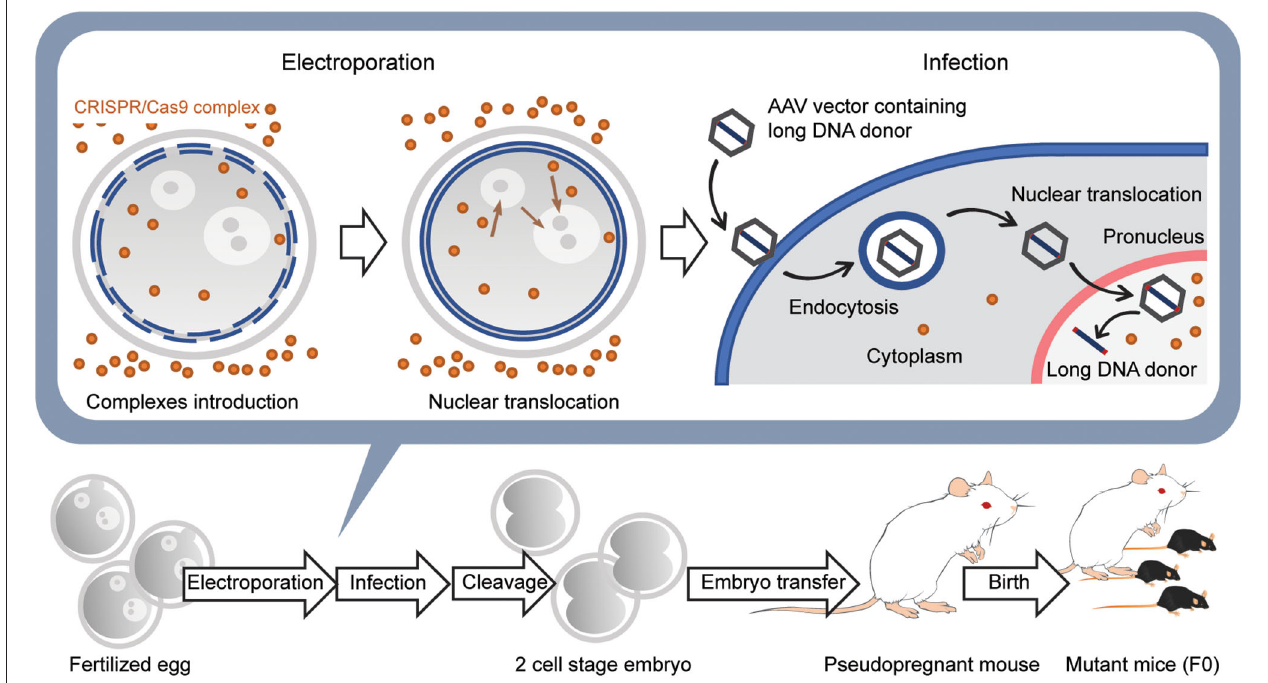
FIGURE 5 | Generation of knockin mice with a long transgene using AAV viral vectors. First, CRISPR/Cas9 complexes are introduced into the fertilized egg using electroporation without long DNA donors. Next, the embryos are moved to the medium containing the AAV vector with the long DNA donor and infected with the viral vectors. The AAV vectors are introduced into the cytoplasm by endocytosis and then translocated into the nucleus using several pathways. The long DNA donors contained in AAV vectors are released in the nucleus and are used for HDR together with the CRISPR/Cas9 complex that was previously transferred into the nucleus. Embryos developed at the 2-cell stage the next day are transferred into the oviducts of the pseudopregnant female mouse, and 18–20 days later, F0 mice are